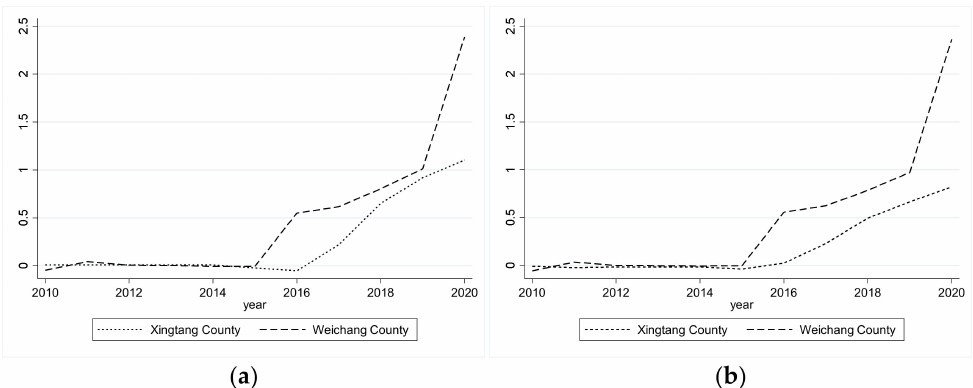
Figure 6. Effect of the CFFP on herbivorous livestock development; ( a ) effect of herbivorous livestock production levels; ( b ) effect of the herbivorous livestock production concentration index